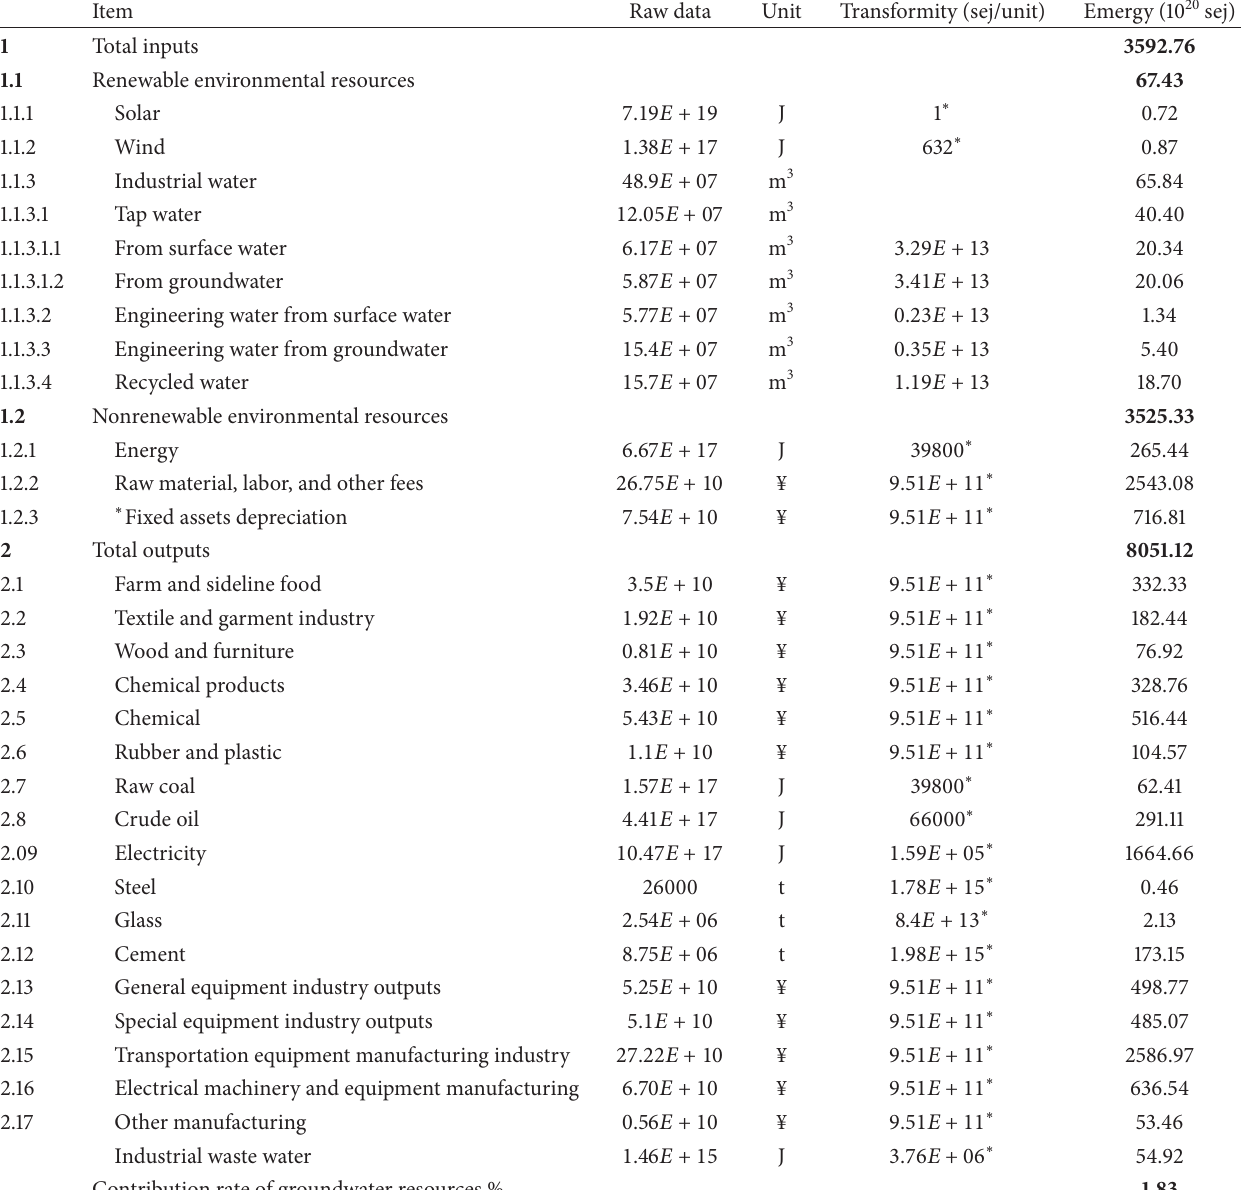
Table 4: Emergy inputs and outputs within and outside BIS (Beijing industrial system),